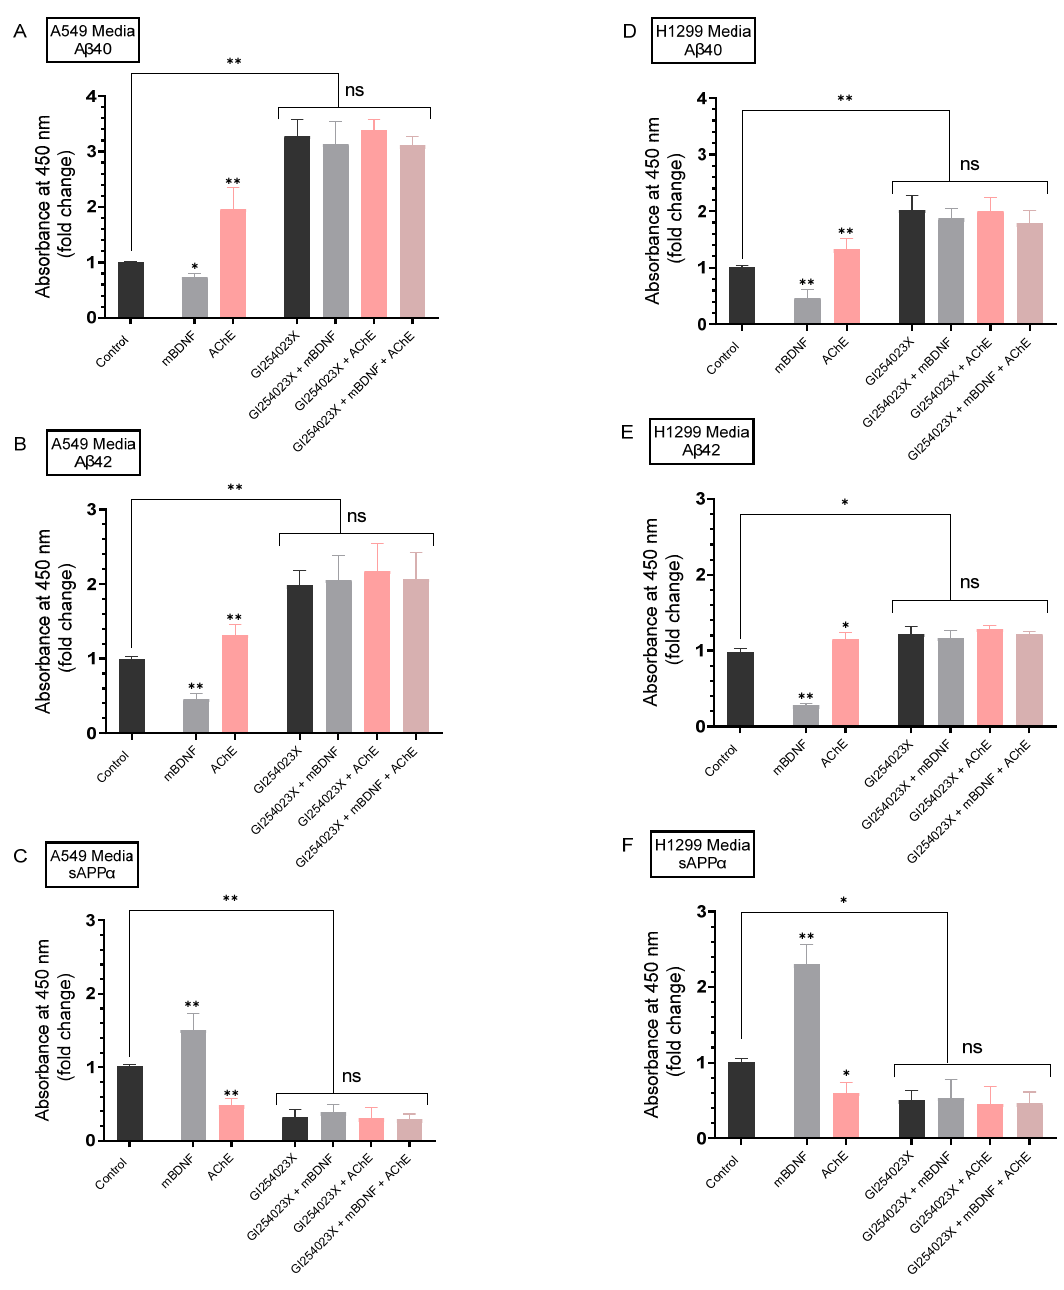
Figure 5. mBDNF decreases the amount of A β which correlates with increased sAPP α released from cells in an α -secretase-dependent manner while the converse was observed by AChE treatment. Cells (0.2 × 10 5 ) were grown in 10% FBS-supplemented media for 24h. The following day, the cell monolayers were incubated in serum-free media for 24h, then treated for 72h with the ADAM10 inhibitor (GI254023X, 10 μ M), mBDNF (5 nM), AChE (60 nM) or in combination. Levels of A β 40 (A, D), A β 42 (B, E), and sAPP α (C, F) released into the culture media during the 3-day incubation period were measured as described in the Methods section on the same amount of protein (3 μ L of 600 μ g/mL total protein) of each sample. Data from five independent assays, each carried out in triplicate, were averaged, normalized, and expressed as fold change relative to untreated cells (control) using the GraphPad 9.4.1 software. The graphs summarize the results expressed as means ± SD (n = 5). Asterisks (*) indicate a statistically significant difference from the corresponding control of each cell line. Mann-Whitney test, *p<0.05, **p<0.0l.